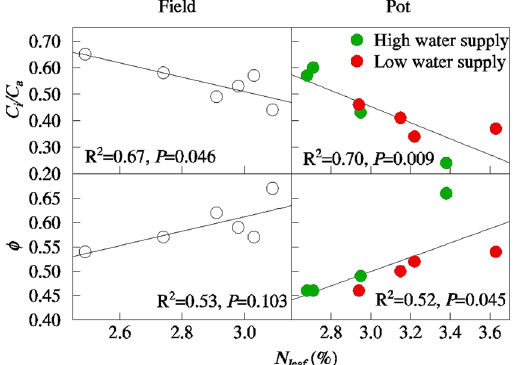
i / C a ), leaf nitrogen concentration ( N leaf ), bundle sheath leakiness ( Ф ), and carbon isotope discrimination ( in Cleistogenes squarrosa grown under variable N and water supply in the pot experiment. Error bars indicate standard error (N = 4). Different letters indicate significant differences between treatments at P = 0.05.